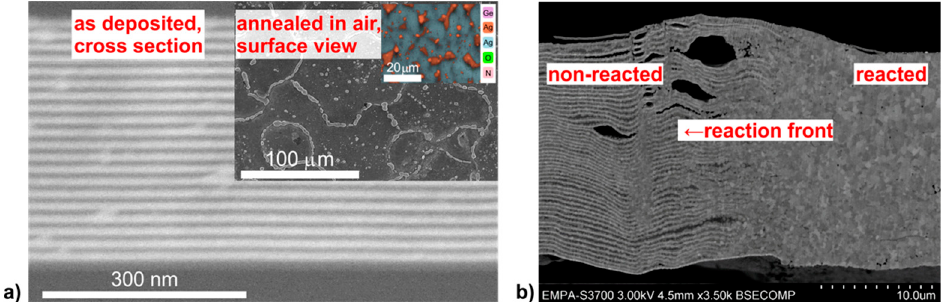
Figure 2. Nanomultilayers: A new class of joining materials: ( a ) non-reactive Ag/Ge/AlN nanomultilayer as a nanostructured brazing material for fast, low-temperature joining processes; ( b ) reactive Ni/Al nanomultilayer as a local heat source for bonding of heat-sensitive materials or for offside joining work (SEM cross-section).